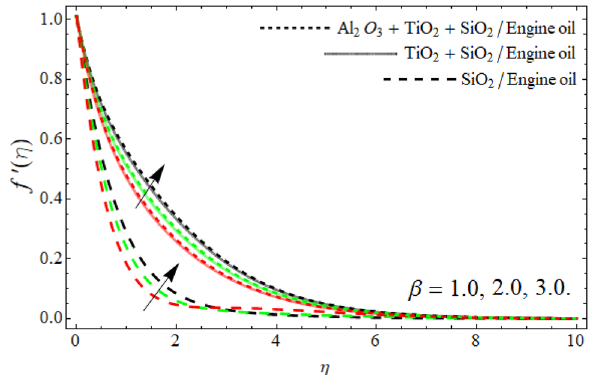
Figure 2. Velocity f ′ (η) field versus ferrohydrodynamic interaction number β